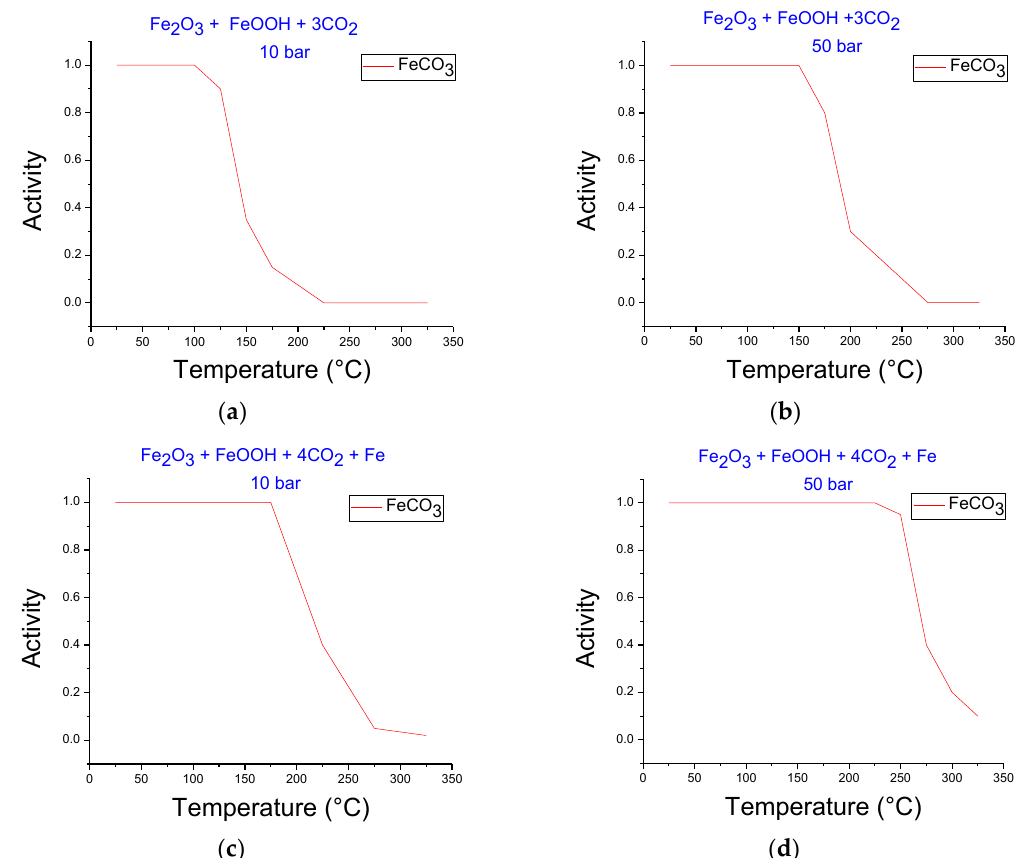
Figure 3. FACTSAGE simulations at various temperatures for the system iron ore–CO 2 , ( a ) 10 bar, ( b ) 50 bar, and for the system iron ore–CO 2 –Fe ( c ) 10 bar, ( d ) 50 bar.